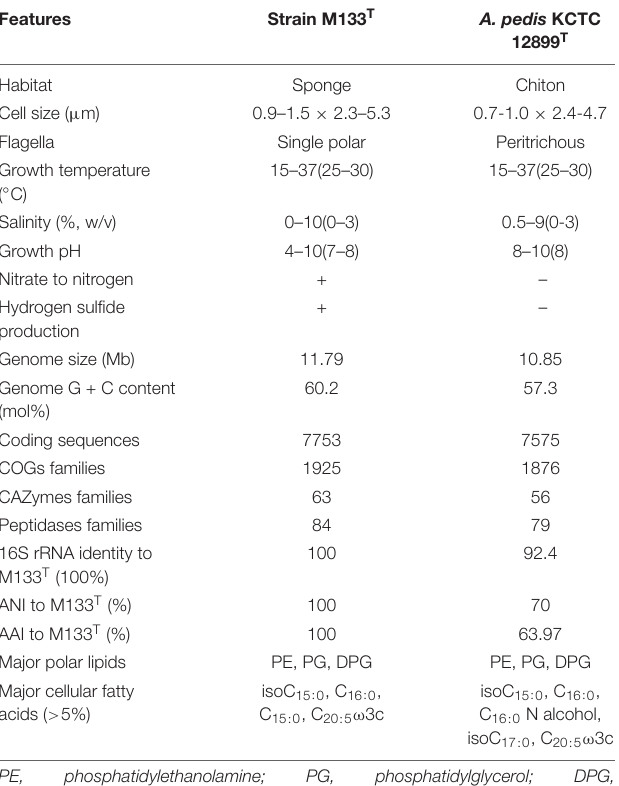
TABLE 2 | Characteristics distinguish strain M133 T from Acanthopleuribacter pedis KCTC 12899 T .